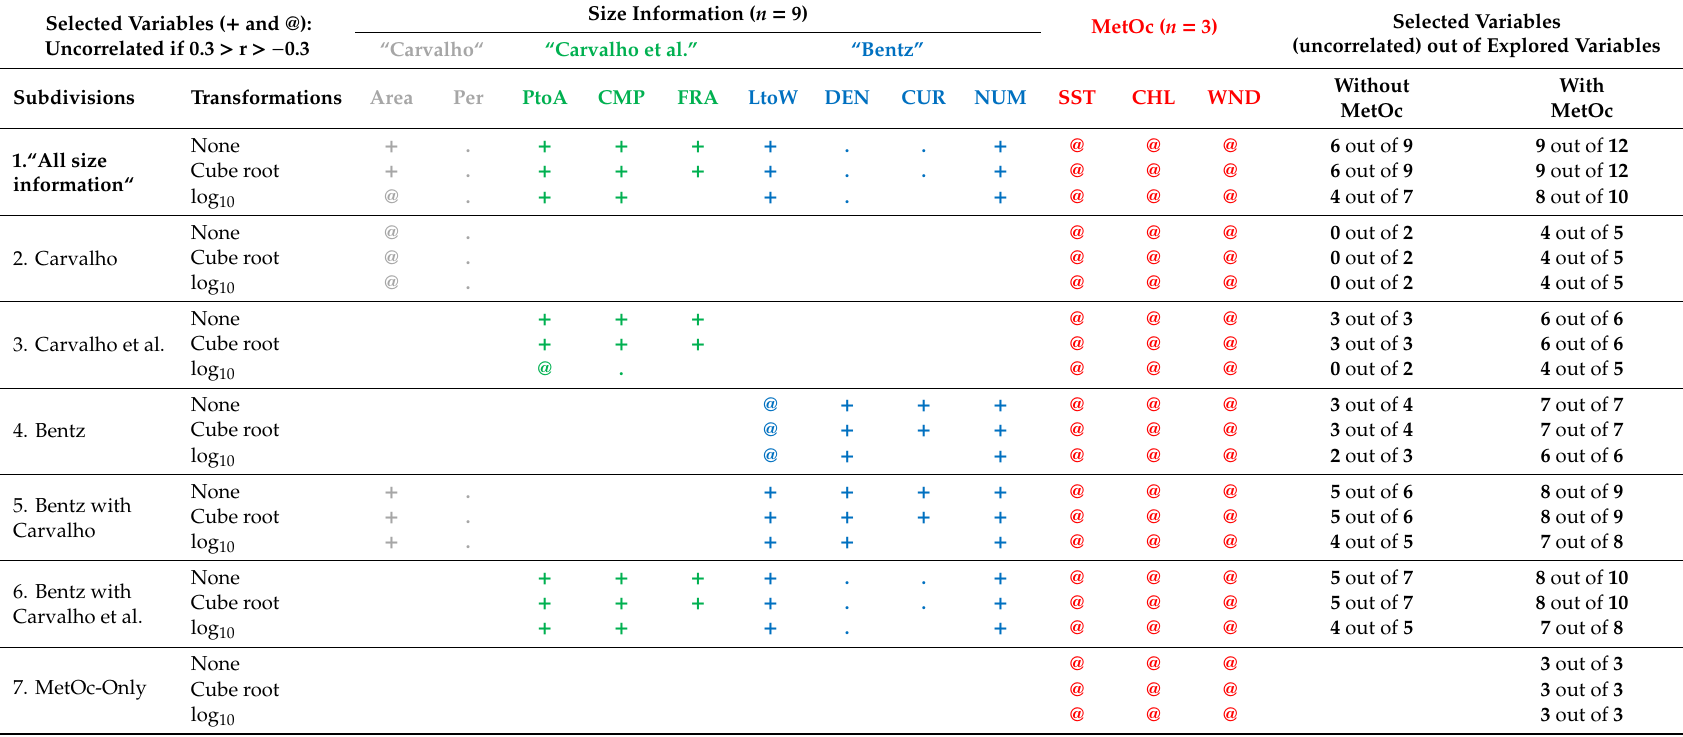
Table 5. Feature selection outcome from the Unweighted Pair Group Method with Arithmetic Mean (UPGMA) dendrogram analyses performed on several attribute–domain subdivisions with three non-linear transformations (none, cube root, and log 10 ), with and without the Meteorological and Oceanographic ancillary information (MetOc): uncorrelated selected variables (Pearson’s correlation coe ffi cient: 0.3 > r > − 0.3) both with and without MetOc ( + ) and only with MetOc (@). Variables not explored per subdivision have an empty cell. Variables not selected due to statistical correlation (0.3 < r < − 0.3) are marked with a dot. Gray subdivision ( n = 2): “Carvalho” refers to [18,21], see Section 2.3.2. Green subdivision ( n = 3): “Carvalho et al.” corresponds to [22–24], see Section 2.3.3. Blue subdivision ( n = 4): “Bentz” is associated to [17]. Red subdivision ( n = 4): MetOc-Only subdivision. Additional information on the origin of the variables subdivisions is found in Sections 3.2 and 3.3. See text for color-coding used only to facilitate the visualization (Section 3.3.1). Explored variables ( n = 12): Area; Per (perimeter); PtoA (perimeter-to-area ratio); CMP (compact index: 4. π .Area / Per 2 ); FRA (fractal index: 2.ln(Per / 4) / ln(Area)); LtoW (length-to-width ratio); DEN (density); CUR (curvature); NUM (number